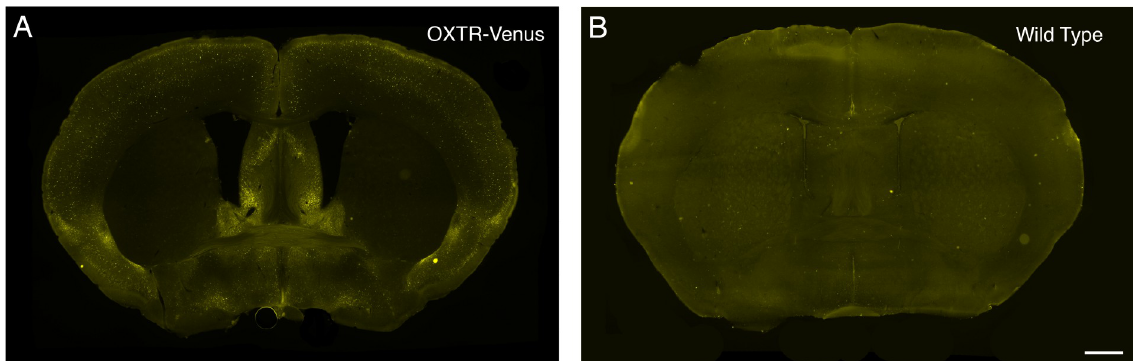
Fig 1. Fluorescent photomicrographs of coronal sections from a female OXTR-Venus mouse and a female wild type mouse. Immunocytochemistry using an anti-GFP antibody was conducted to enhance and preserve the fluorescent signal from Venus. A. Numerous immunoreactive OXTR-Venus cells were observed in various regions in the section from an OXTR-Venus mouse. B. No immunoreactive-cells were observed in the brain section from a wild type mouse. Scale bar = 1